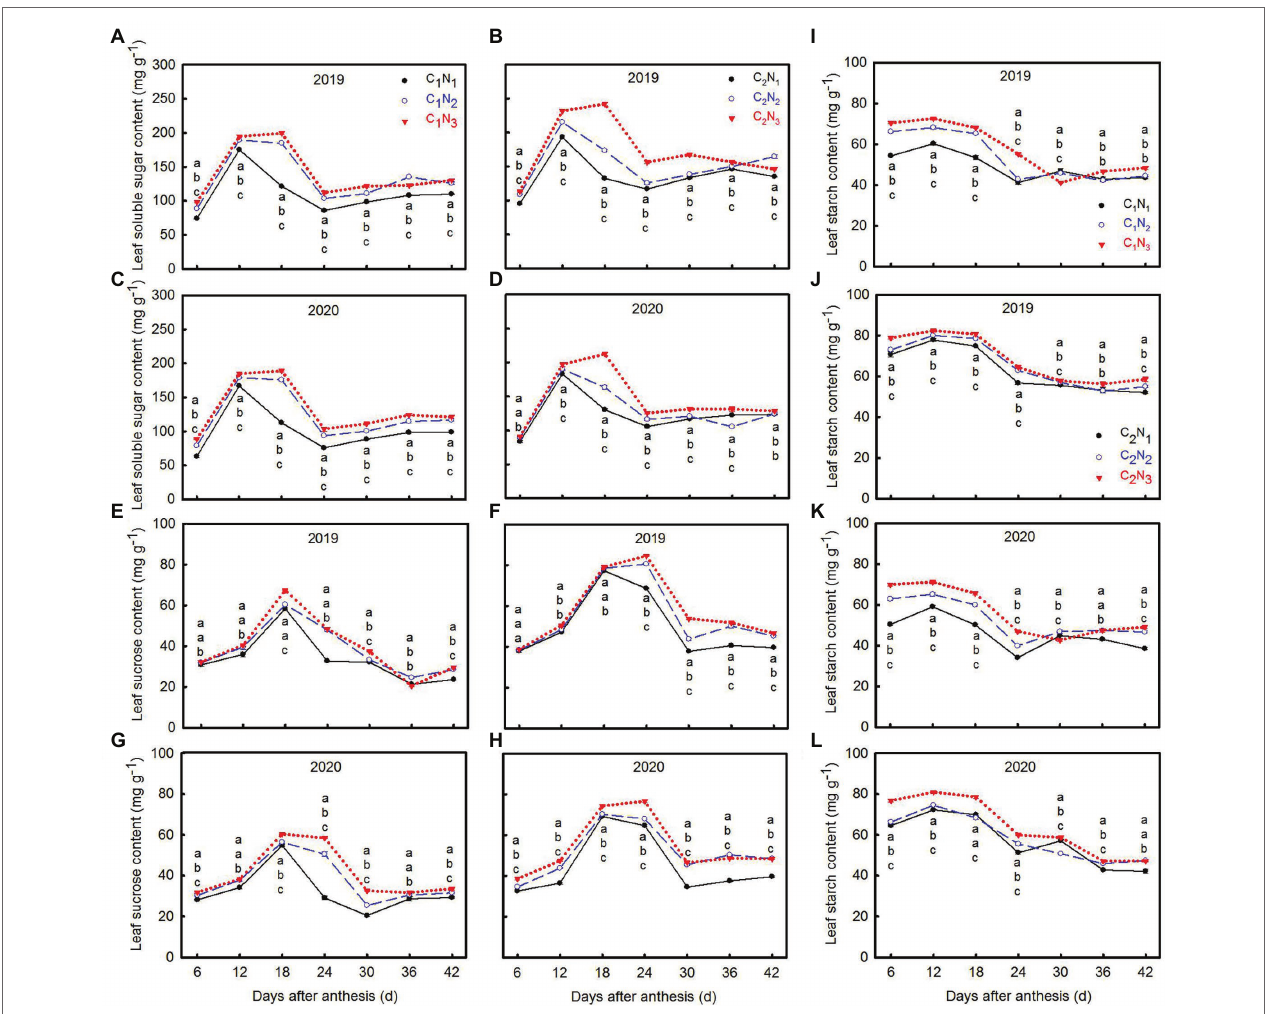
FIGURE 3 | Changes of soluble sugar (A–D) , sucrose (E–H) , and starch (I–L) contents in top three leaves at 6, 12, 18, 24, 30, 36, and 42 days after anthesis under different N application rates. Data are mean ± SE ( n = 3). Different lowercase letters from top to bottom indicate statistical difference between treatments at the 0.05 level according to the LSD test. C 1 : Chuannongyou 508; C 2 : Shuangyou 573; N 1 : 75 kg ha − 1 ; N 2 : 150 kg ha − 1 ; N 3 : 225 kg ha − 1